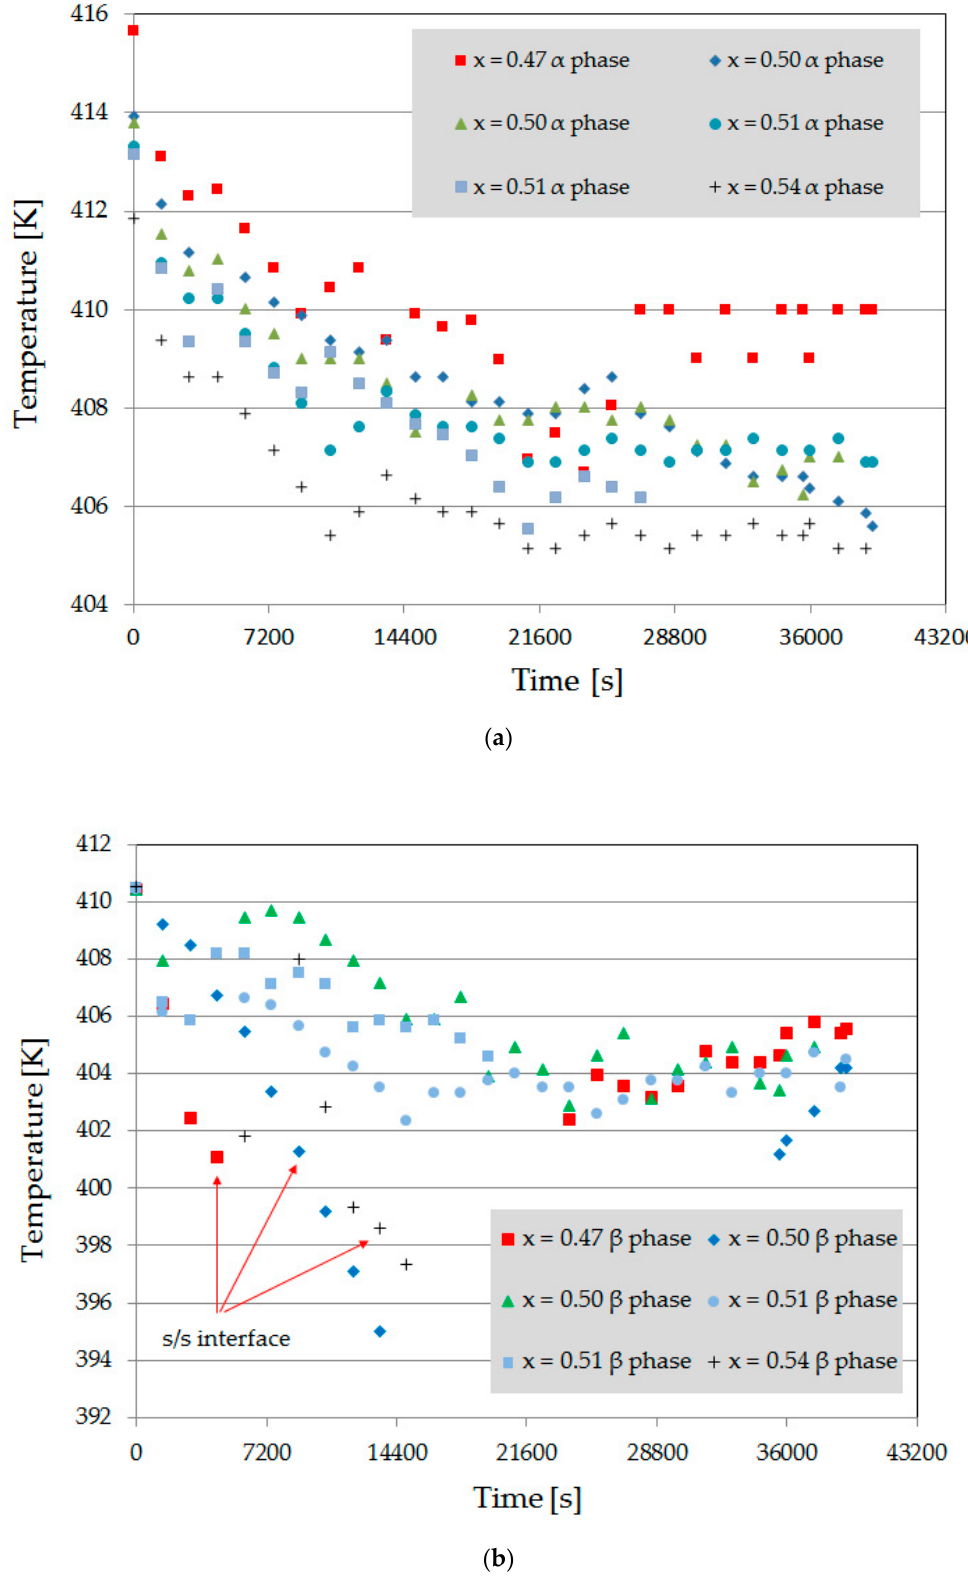
Figure 11. ( a ) Time dependent temperature level of the s/l interface for the primary α -phase and ( b ) the s/l and s/s interfaces of the peritectic β -phase.